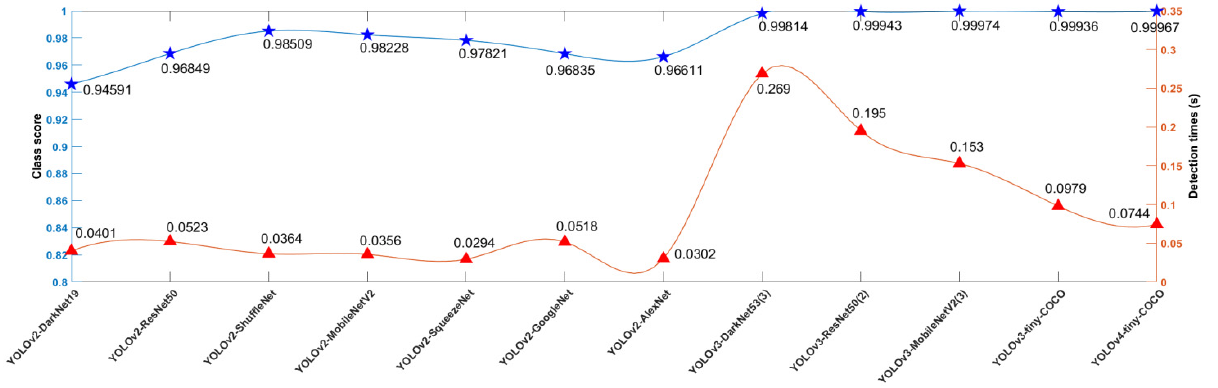
Figure 10. Comparison of model test results.